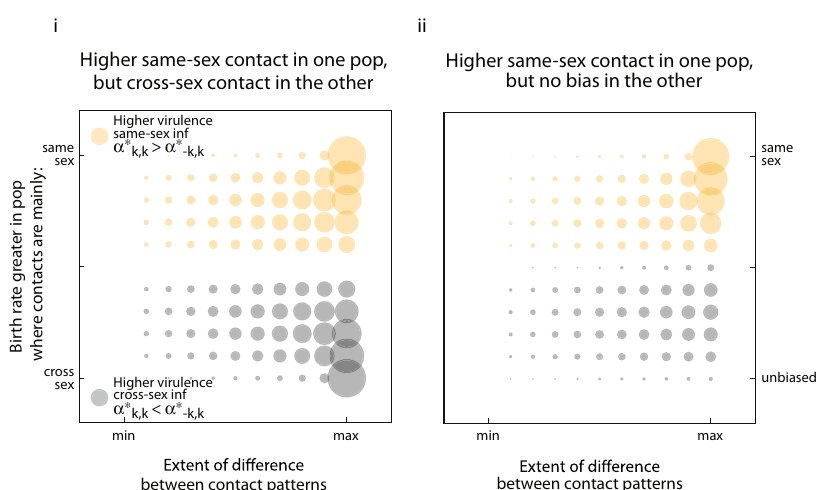
Fig. 6 Evolution of origin-&-sex-speci fi c virulence when subpopulations differ in contact structure and population size. The difference between average virulence associated with infections acquired from same-sex transmission, de fi ned as (cid:2) α (cid:3) kk ¼ ð α 11 þ α 22 Þ = 2, and those acquired from cross-sex transmission, de fi ned as (cid:2) α : kk ¼ ð α 12 þ α 21 Þ = 2, is plotted here as circles whose area scales with the extent of the difference. Circles are centred according to the relationship between the contact patterns that exist in the respective subpopulations, and the extent of the bias in birth rate between subpopulations. These numerical results assume no sex-speci fi c differences in transmissibility or susceptibility ( β (cid:129) ← (cid:129) ), no sex-speci fi c background mortality, no possibility of recovery, and weak mixing of populations ( σ = 0.25). In sub-panel i , there is higher same-sex contact in one subpopulation but lower in the other. As the difference with respect to contact patterns between the populations increases, contacts in one subpopulation become more strongly biased toward same- sex interactions while those in the other subpopulation become equally biased but toward cross-sex interactions. Opportunities for the creation of new infections can be strongly associated with same-sex interactions when the in fl ux of new susceptible hosts through birth strongly favours the population with that contact pattern. Birth rates may also be greater in the subpopulation associated with cross-sex interactions, in which case the negative consequences of pathogen virulence are lower there and greater cross-sex virulence evolves. In sub-panel ii , there is higher same-sex contact in one population but no bias in the other. This assumes no bias in the same-sex vs cross-sex pattern of contact in one of the two subpopulations. In this case the opportunity to create new infections ranges between same-sex bias and no bias as the in fl ux of new susceptible hosts shifts through births from favouring one subpopulation to favouring the other.